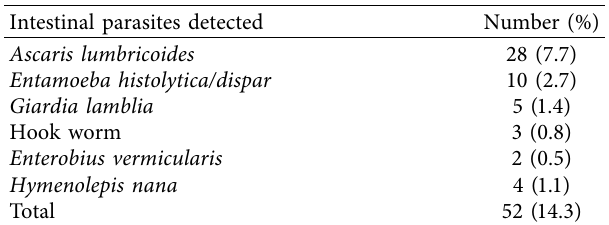
Table 2: Prevalence of intestinal parasite among food handlers in Woldia town, North-East